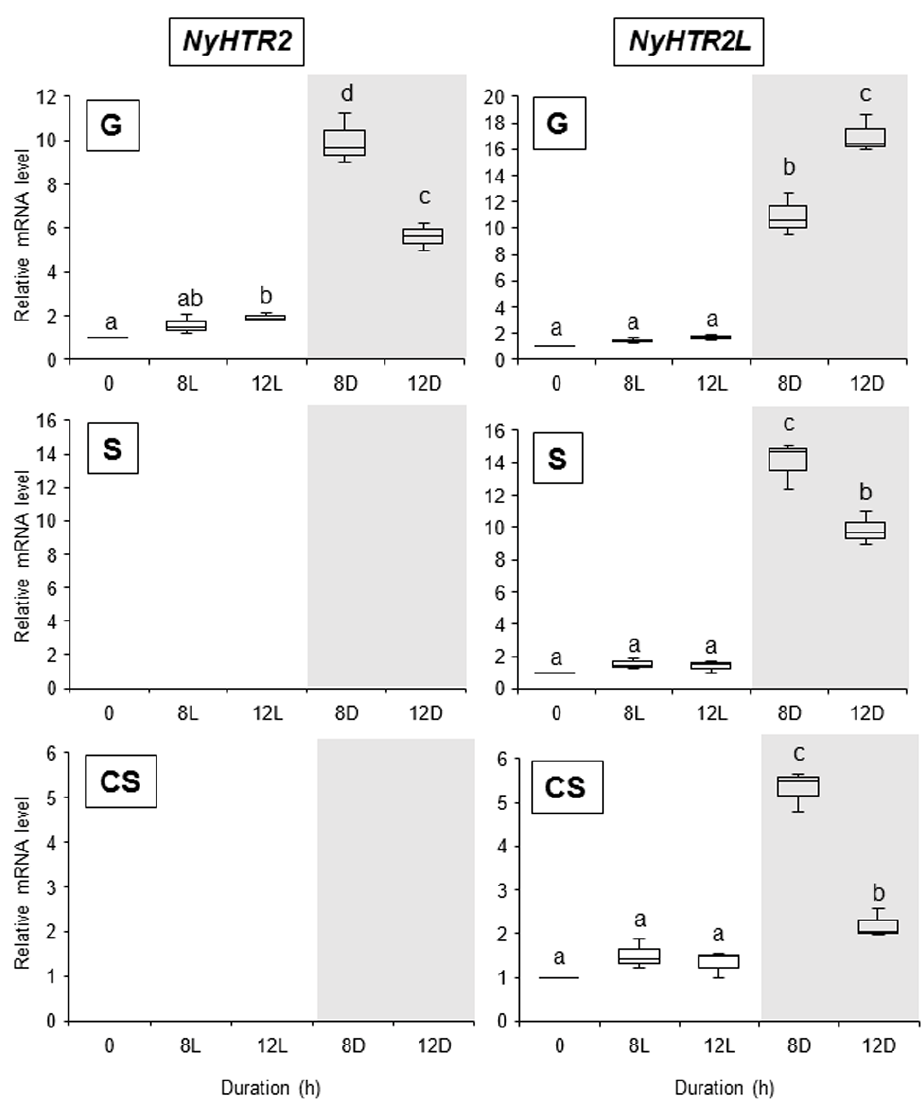
Figure 3. Effect of dark treatment on the second expression peak of NyHTR2 and NyHTR2L in three life cycle generations of Neopyropia yezoensis at 25 °C. Gene expression in the light and the dark, at 8 and 12 h after heat stress exposure, was compared. Relative mRNA levels were normalized using eIF4A as the reference gene. In the box plots, values on the Y axis represent the fold change of relative quantification of each gene. Since no expression of NyHTR2 was observed in sporophyte and conchosporophyte, nothing is displayed in corresponding panels in the figure. Different alphabetical letters denote significant differences in expression level among the three life cycle generations from triplicate independent replicates as defined by Tukey’s test ( p < 0.05) in two-way ANOVA. L—light; D—dark; G—gametophyte; S—sporophyte; CS—conchosporophyte.